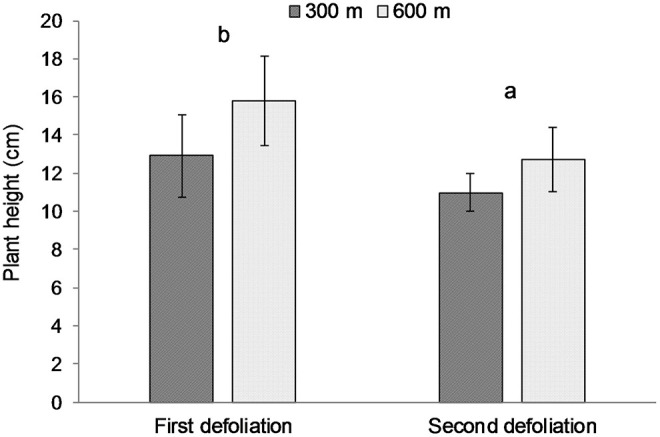
Average heights of the same plants at the time of the first and second defoliation, respectively, at 300 and 600 m from water sources. Error bars represent Standard Error of the Means. Lowercase letters indicate significant (p < 0.05) differences among defoliation time.